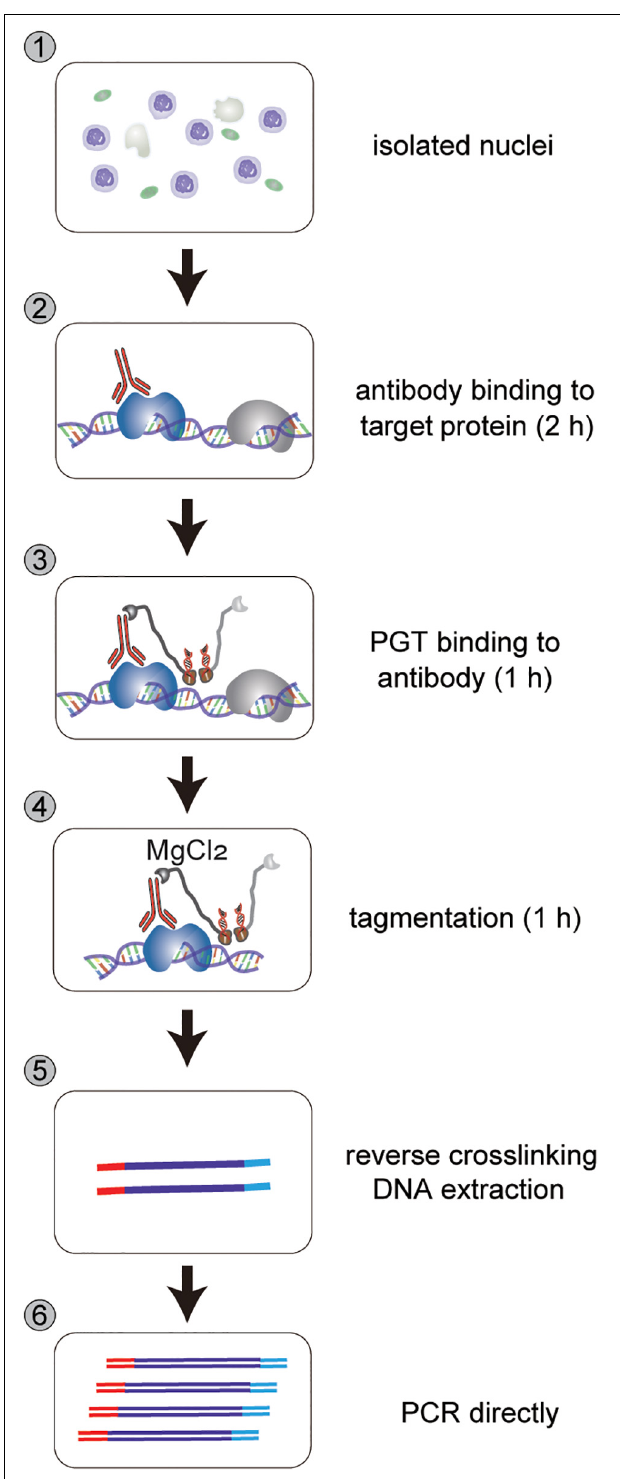
FIGURE 2 | Workflow of nCUT&Tag. nCUT&Tag starts with isolated nuclei, followed by antibody binding to target protein for 2 h, PGT binding to antibody for 1 h, tagmentation for 1 h, reverse crosslinking, and direct PCR for library DNA enrichment. For fresh tissue, reverse crosslinking (step 5) can be omitted. Tagmentation DNA is purified directly using a DNA Purification